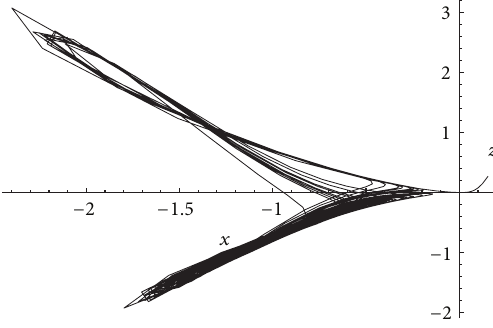
Figure 6: Solution 𝑦(𝑡) for 𝛼 = 0.96 .